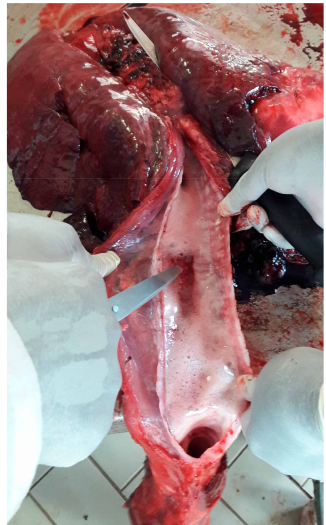
Figure 5: Bilateral red hepatization of the lungs, frothy airways, and congested tracheal